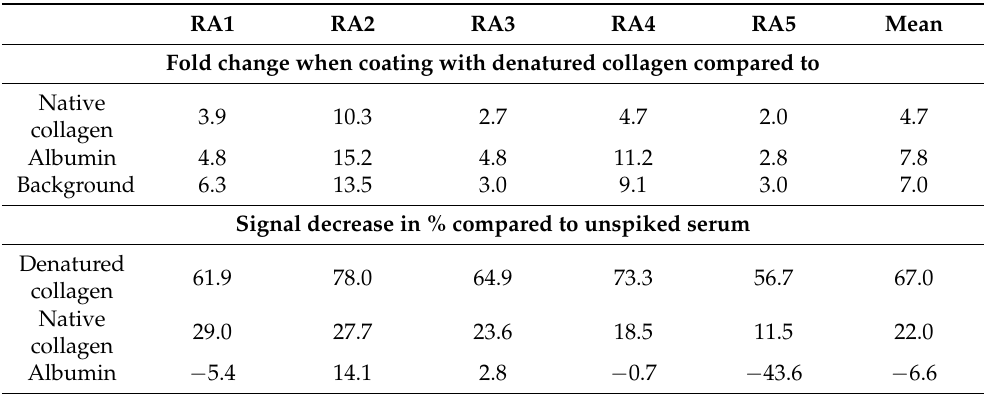
Table 1. Cont . Assay Parameters Results Analyte recovery, 4 freeze–thaw cycles, mean (range) Antibody stress Up to 24 h at 20 ◦ C Hemoglobin recovery >120% Lipids Recovery (low)(high) LLMR: lower limit of measurement range, ULMR: upper limit of measurement